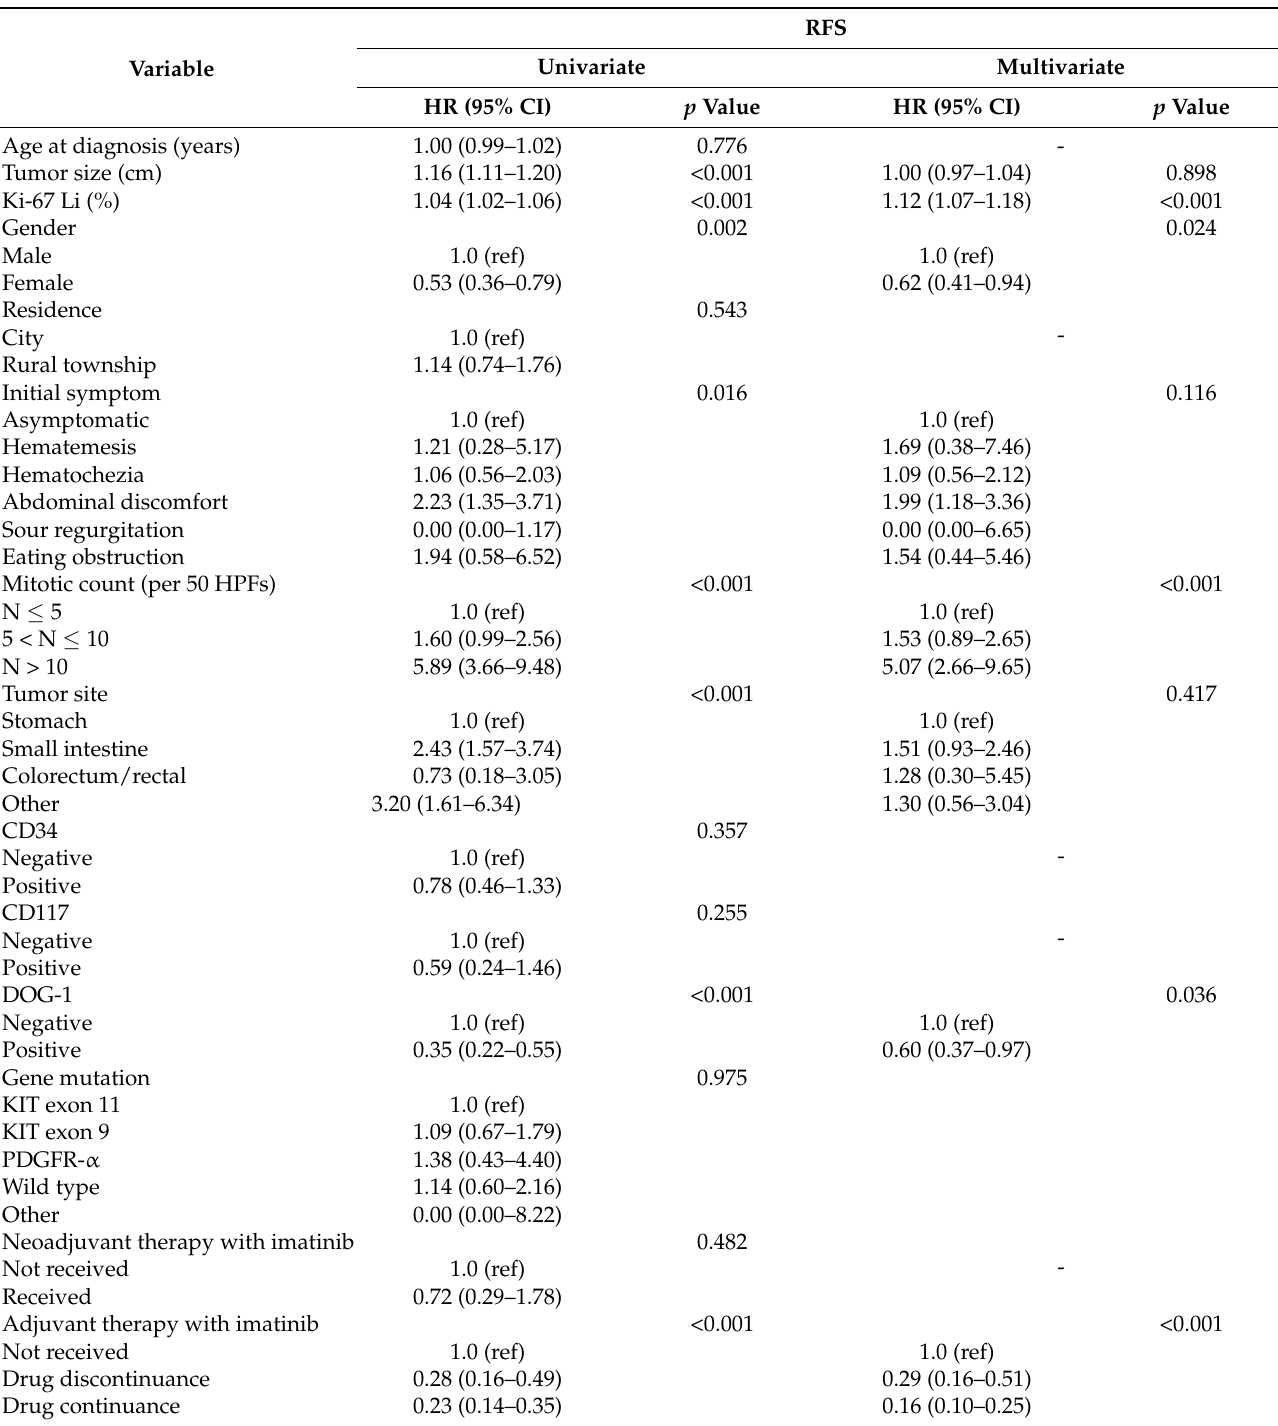
Table 2. Univariate and multivariate Cox analysis of prognostic variables in the training set for the RFS of patients with